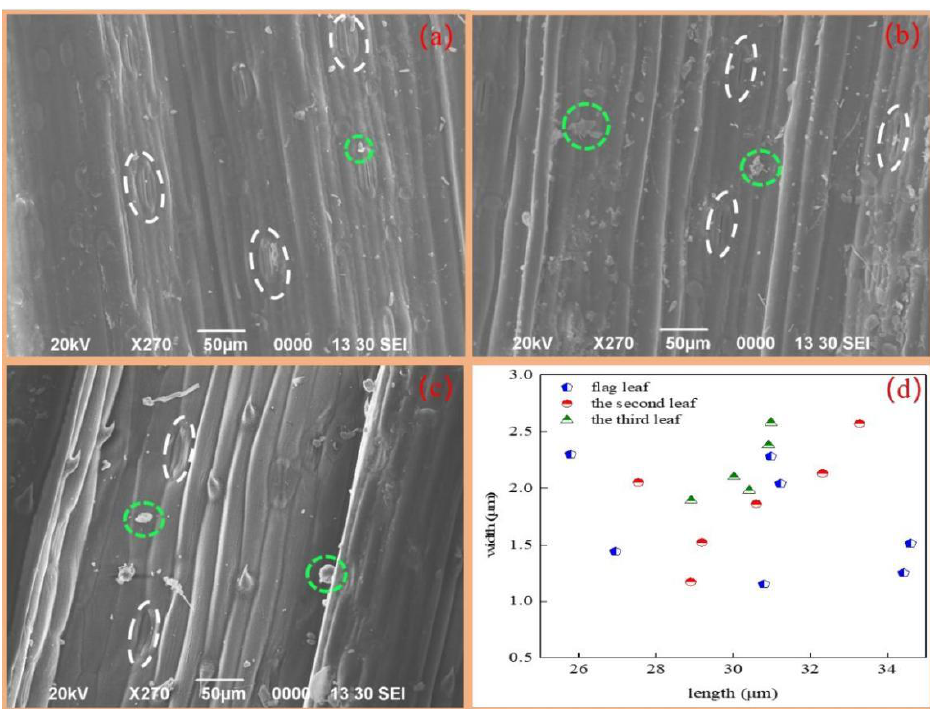
Figure 2. Stomatal distribution of wheat flag leaf ( a ), the second leaf ( b ), the third leaf ( c ), and stomatal pore size map ( d ) of wheat tissues. The magnification is 270 × . Inside the white solid line frame are stomata. Inside the green dotted frame are the atmospheric deposition